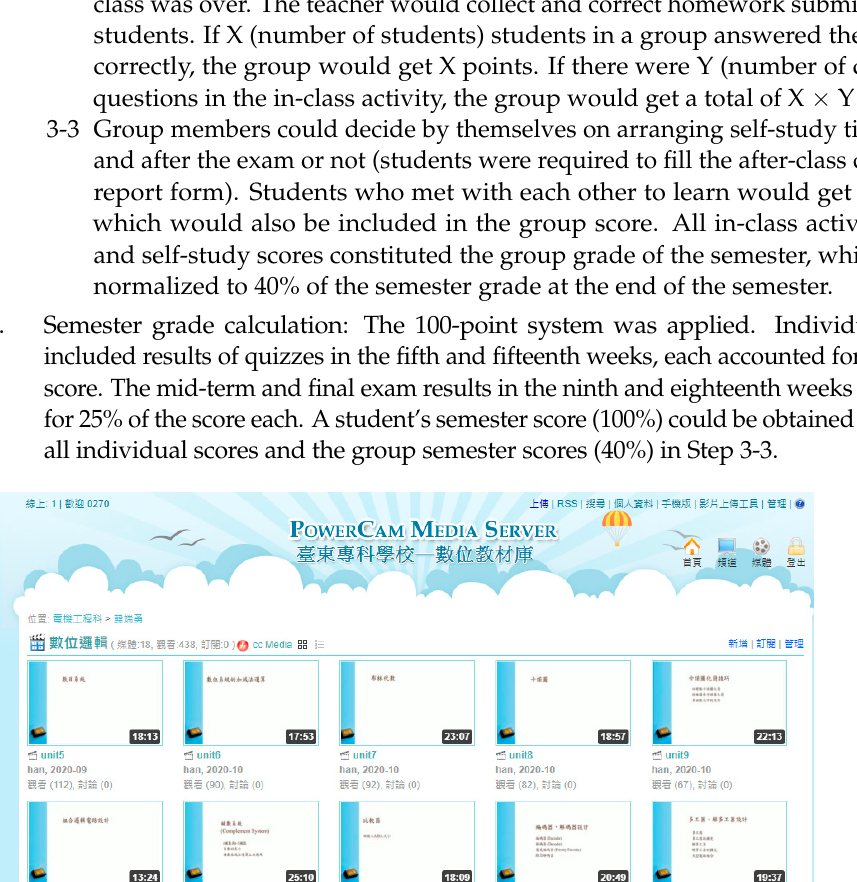
Figure 3. Digital logic course materials stored on the E-learning platform of a junior college in southeastern Taiwan: a snapshot of the slideshow in Unit 7.